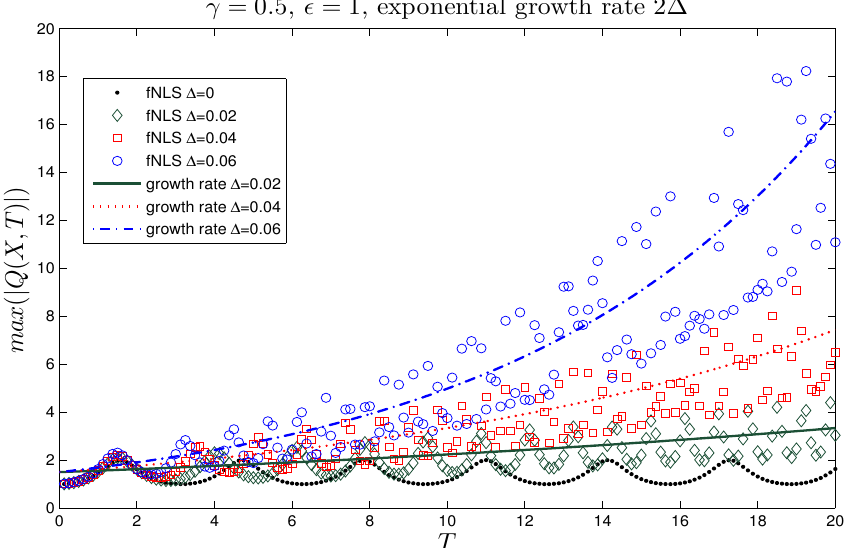
Figure 13. Case 3: Maximum of | Q ( X , T ) | and growth rate 2 ∆ when γ = 0.5, (cid:101) = 1.0, M = 1 for various values of ∆ .